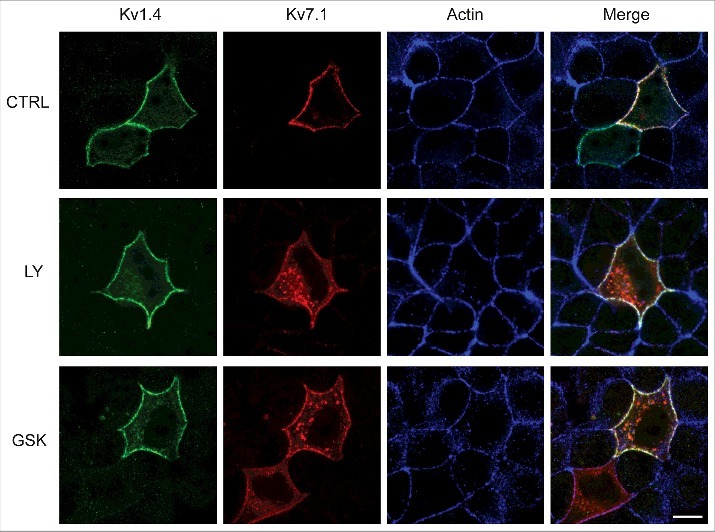
Inhibition of PI3K and SGK1 kinases selectively impacts Kv7.1 localization in polarized MDCK cells. MDCK cells transiently co-expressing Kv1.4 and Kv7.1 were treated with inhibitors of either PI3K or SGK1 for 3 hours before fixation. No effect of the PI3K inhibitor LY-294.002 (10 µM) or the SGK1 inhibitor GSK-650394 (1 µM) was observed upon the subcellular localization of Kv1.4, while Kv7.1 was endocytosed upon treatment with both. Scalebar, 10 µm.